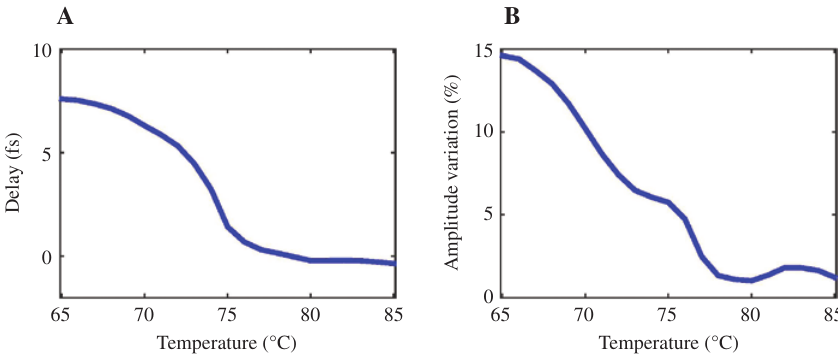
Figure 4: For the devised metasurface of Figure 2A, depending on the temperature of the structure, the delay time can change. (A) The transmission coefficient phase slope represented in the form of a narrow-band pulse delay versus temperature at 150 THz for optical filter in Figure 2A. (B) Maximum amplitude variation of the transmission coefficient in 150 THz ± (5%)